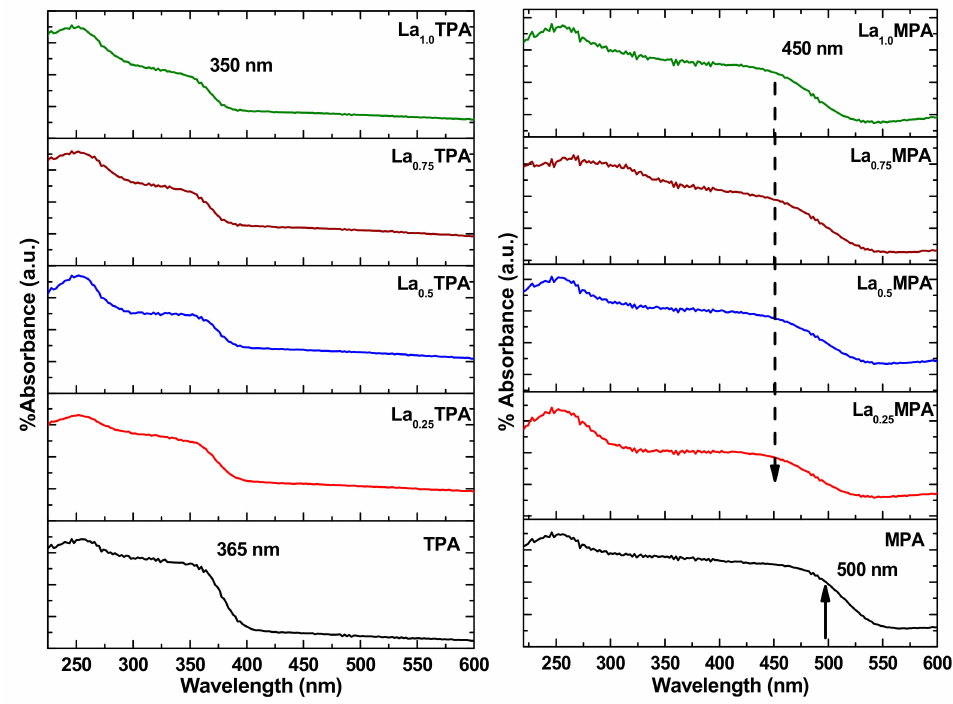
Figure 3. DR UV-vis spectra of La x TPA and La x MPA